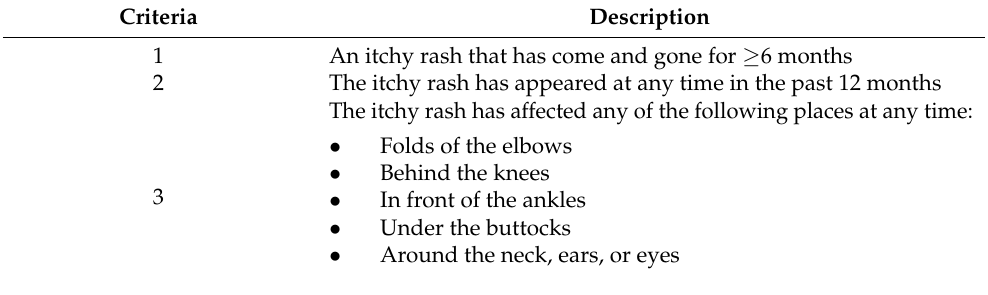
Table 1. International Study of Asthma and Allergies in Childhood Criteria for atopic dermatitis [20]. Criteria